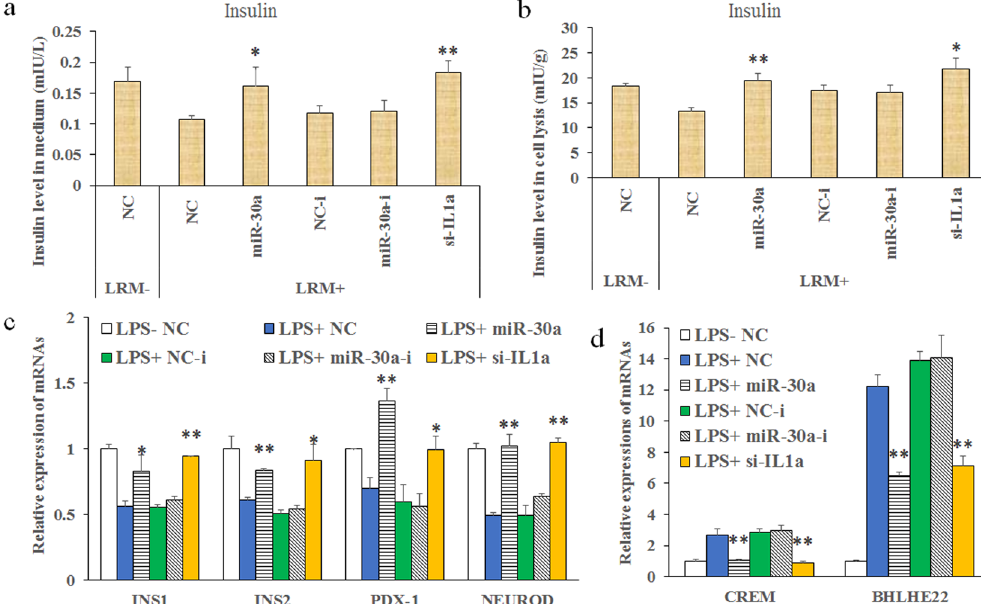
Figure 4. Effects of miR-30a mimics on the insulin levels of cell medium and lysis, as well as mRNA expression in LPS-induced Beta-TC-6 cells. ( a and b ) ELISA showing that miR-30a mimics significantly increased the insulin levels of cell medium and lysis in Beta-TC-6 cells after 24 h of LRM incubation; the insulin levels in cell medium indicated the release of intracellular insulin; and the insulin levels in cell lysis indicated the synthesis of intracellular insulin, which was normalized by the cellular protein concentrations. ( c and d ) RT-PCR showing that miR-30a mimics significantly upregulated the mRNA expression of Ins1, Ins2, PDX-1 and Neurod, while they dowregulated Crem and Bhlhe22 in Beta-TC-6 cells after 12 h of LRM induction. LRM + / − , incubation with or without LRM; NC, negative controls of miRNA mimics; NC-i, negative controls of miRNA inhibitors or siRNA; miR-30a-i, miRNA-30a inhibitor; and si-IL1a, silencing mRNA fragment of Il-1a. Data are expressed as the Mean ± SD (n = 3); * P < 0.05 and ** P < 0.01 vs. NC or NC-i (LPS/LRM + ),